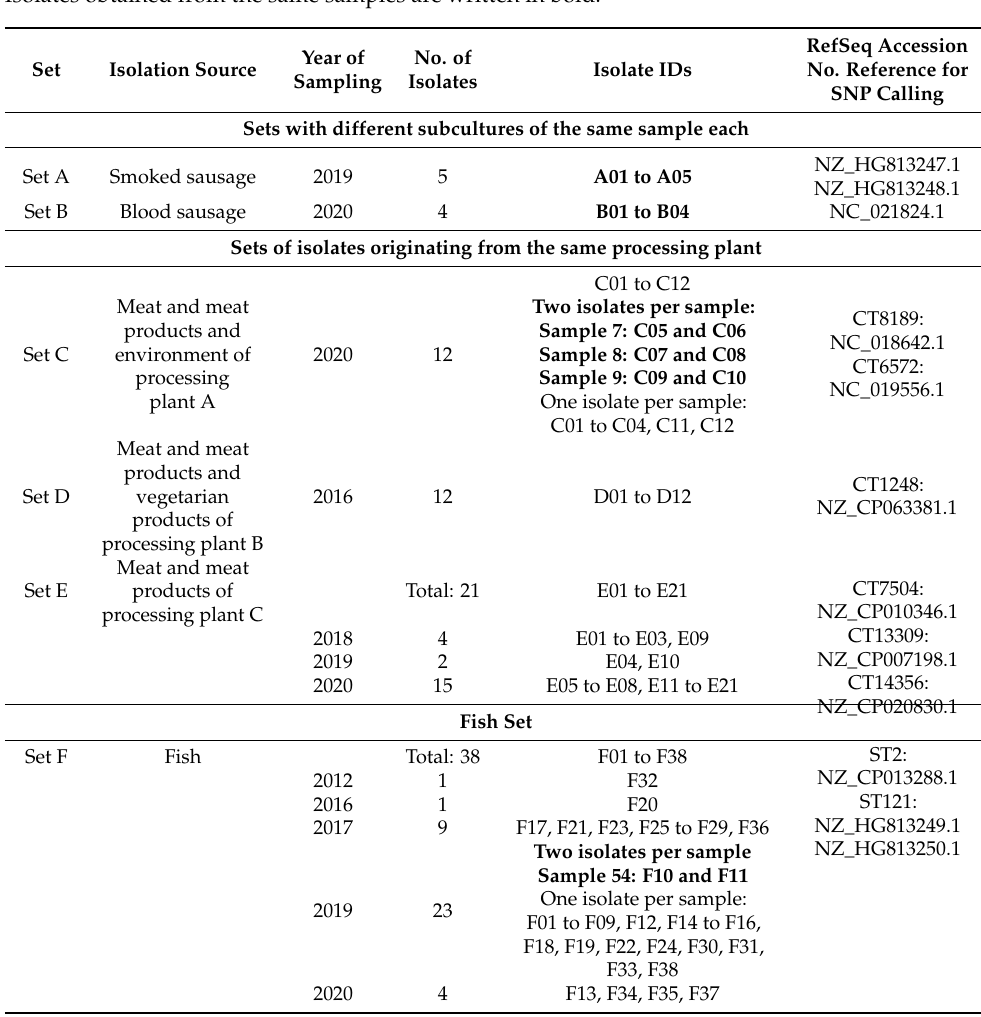
Table 1. Overview of all isolates analyzed in this study and their classification into different sets. Isolates obtained from the same samples are written in